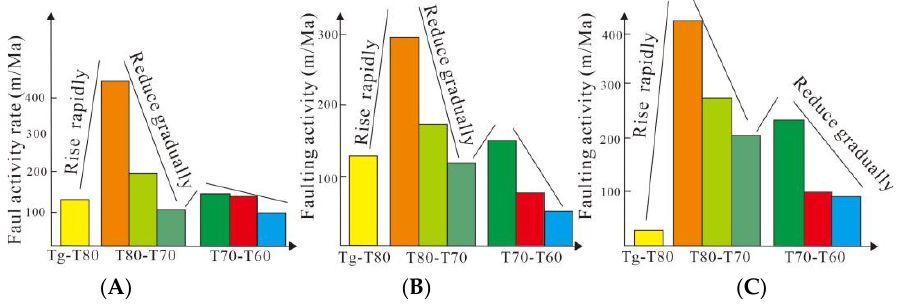
Figure 5. The activity rates of the No. 2 Fault and the No. 11 Fault in the deep-water area of the Paleogene QDN Basin (see Figure 1 for the positions of c , d, and e ). The activity rates show the characteristics of three phases. Inside each phase, the fault activity rate first rose rapidly to a peak value and then reduced gradually to a minimum value. ( A ) point c in No. 2 Fault; ( B ) point d in No. 2 Fault; ( C ) point e in No. 11 Fault.